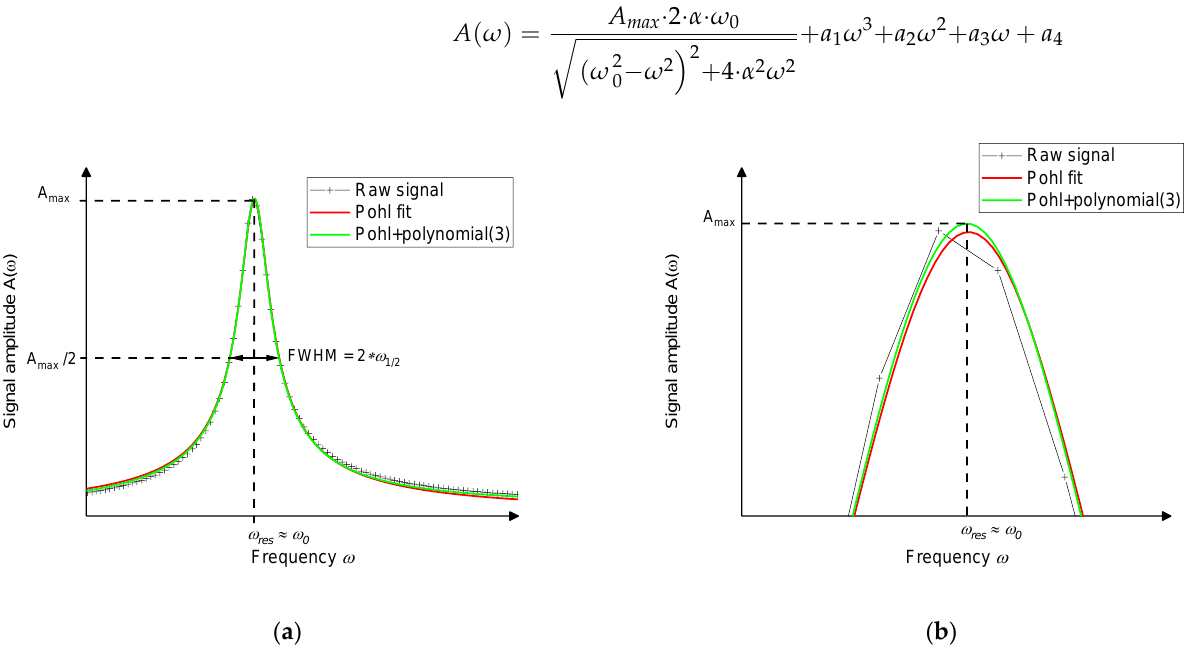
Figure 5. ( a ) The measured peak amplitude (black crosses) and the corresponding fit according to Equation (5) (red curve). The deviation of the red curve and the fitted curve occurs at the falling slope due to the short distance between the respective and the subsequent resonance peak resulting in an overlap of both peaks. By an additional third-degree polynomial, as introduced in Equation (6), the residuum of the fit improves by a factor of 4. The corresponding green curve has less deviation at the increasing and decreasing slopes compared to the red curve. ( b ) Image section of the peak maximum with a higher resolution: Signal noise could result in an incorrect determination of the amplitude peak height and resonance frequency. However, fitting a curve according to Equation (5) or (6) to the measured data, noise-related errors are reduced, which results in an accuracy increase of the sensor system. The differences between the two fitting procedures is less pronounced in this area but can still be seen.